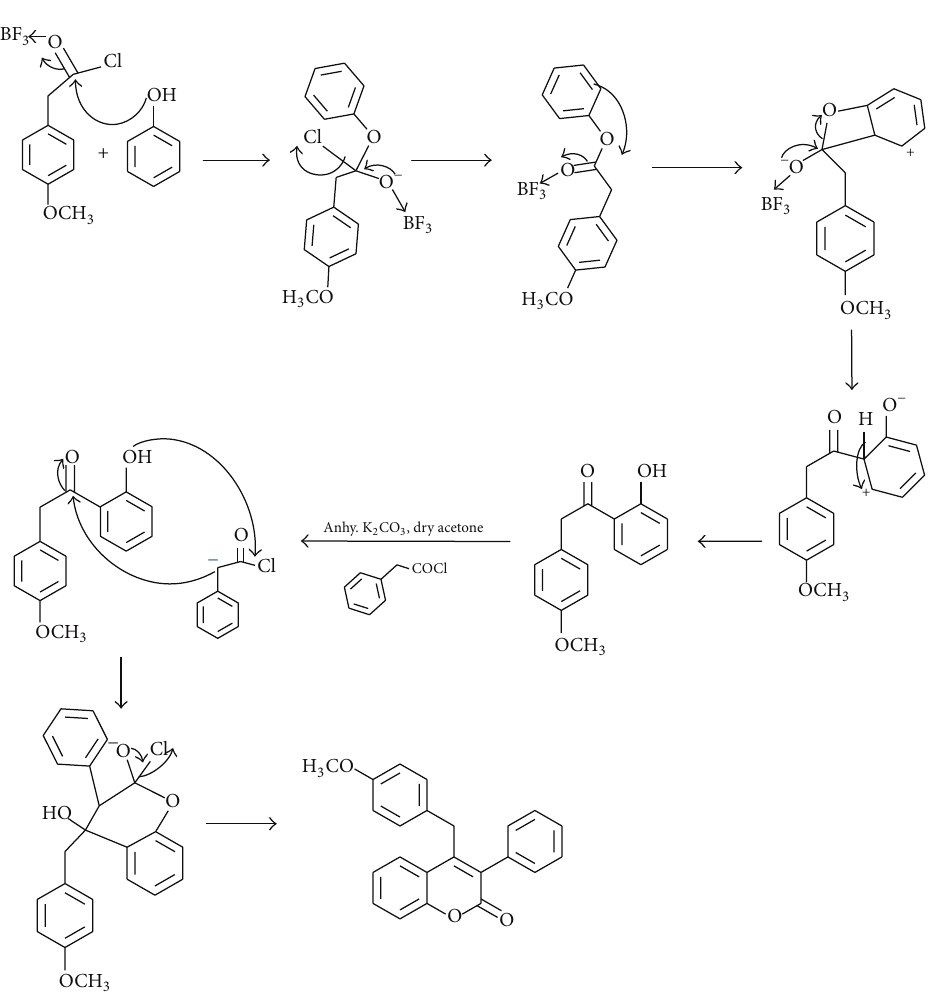
Figure 2: Probable mechanism related to Scheme 2.